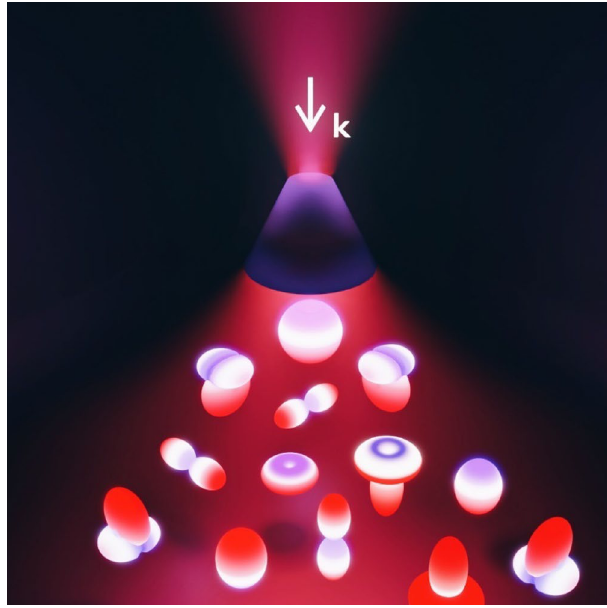
Figure 1. Artistic representation of the considered silicon nanocone particles illuminated with a linearly polarized plane wave, showing the main advantage of the truncated cone geometry over the simpler shapes: the possibility of obtaining various important multipole effects within the same geometric